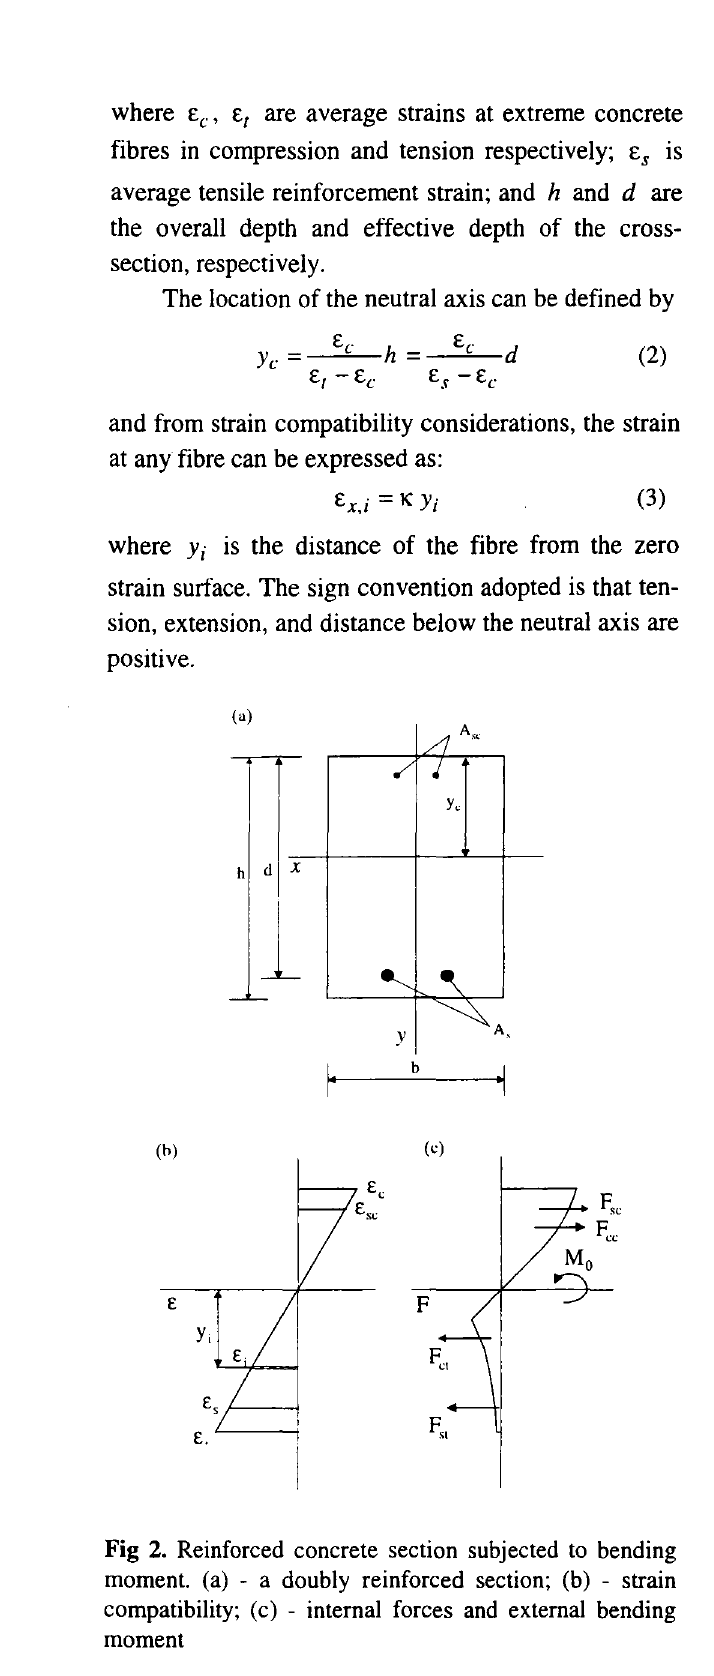
Fig 2. Reinforced concrete section subjected to bending moment. (a) - a doubly reinforced section; (b) - strain compatibility; (c) - internal forces and external